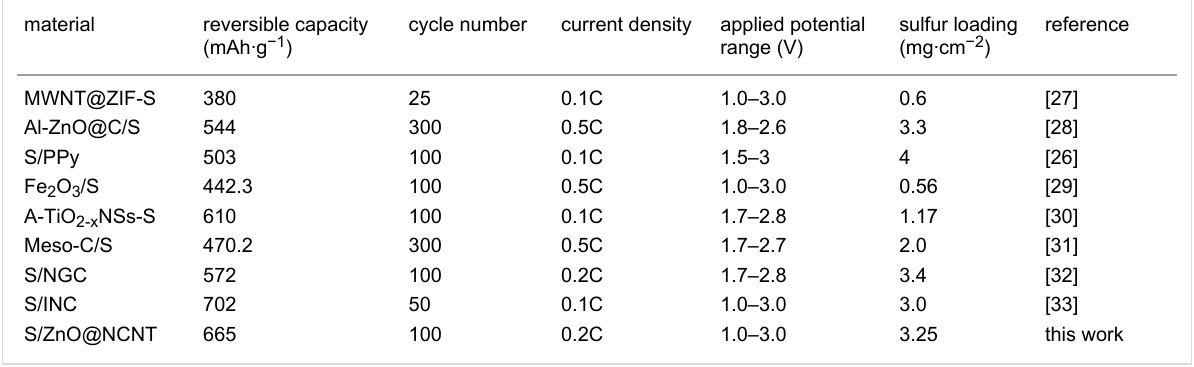
Table 1: Performance comparison of different electrodes for Li/S batteries.